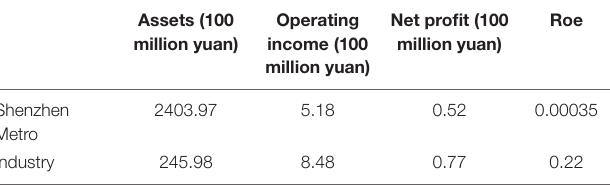
TABLE 3 | Comparison of major financial indicators between Shenzhen Metro and the industry.